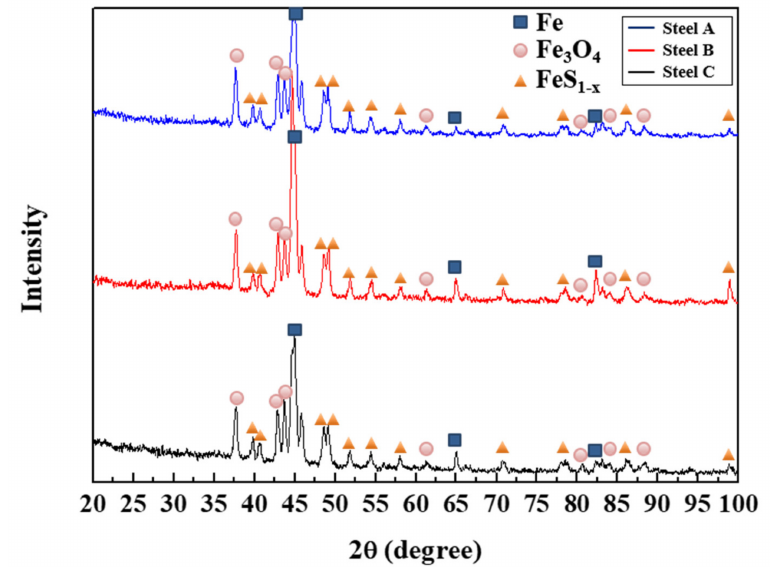
Figure 13. XRD analysis on the corrosion product layer formed on the steel surface after immersion test in a NACE solution with 0.05 M Na 2 S for four weeks.